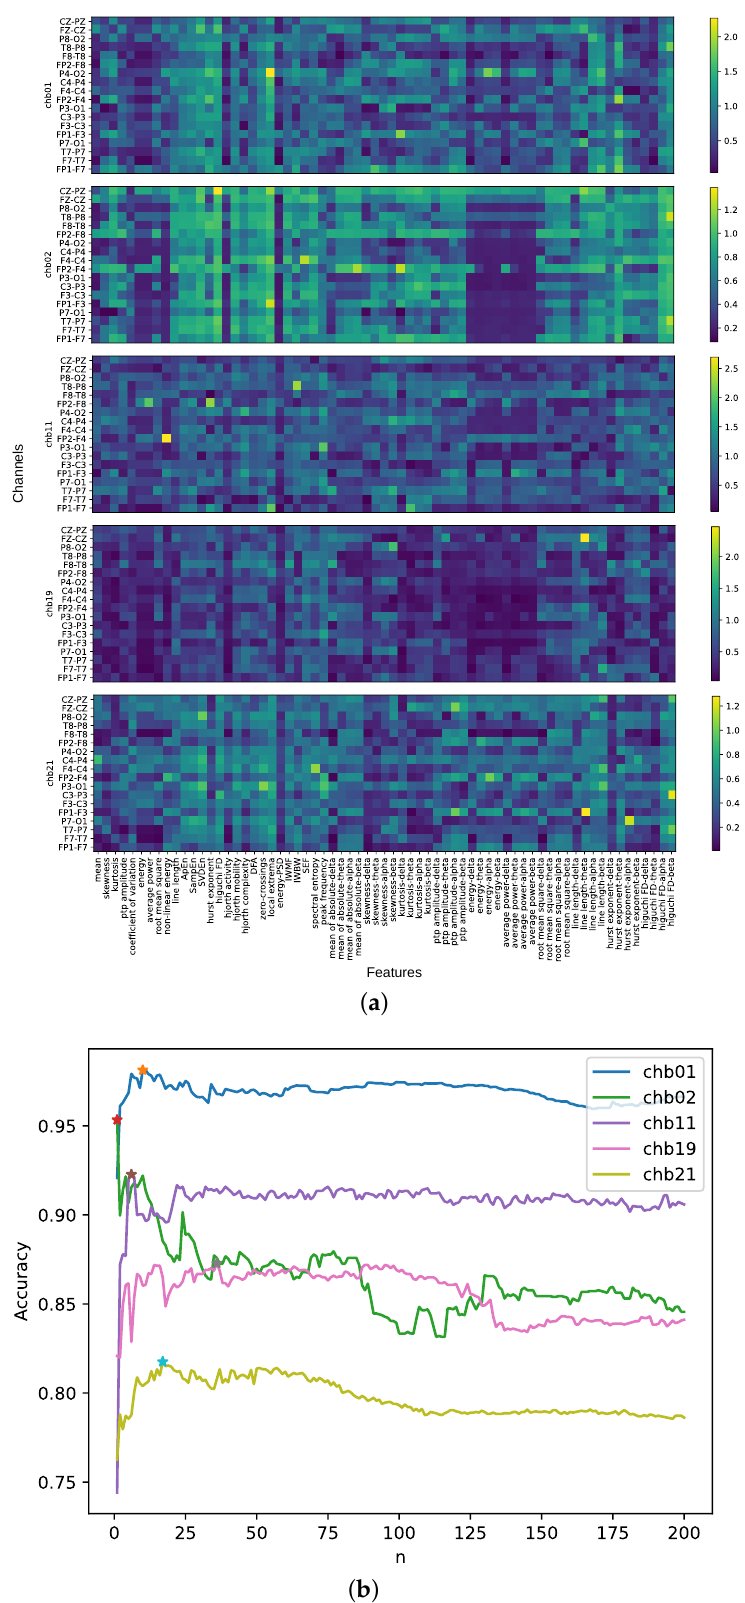
Figure 4. The mRMR scores and accuracy changes of cases chb01, chb02, chb11, chb19, and chb21. ( a ) visualization of mRMR scores. The higher the score, the more valuable the feature-channel is to the patient; ( b ) accuracy with various top n feature-channels subsets, where the selection of feature-channel is based on ( a